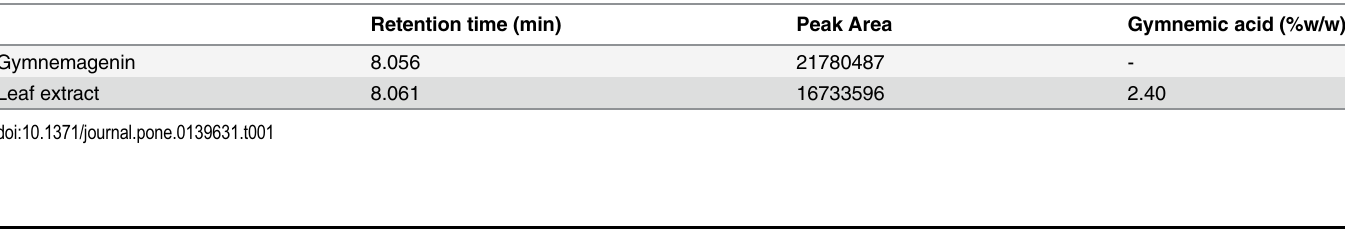
Table 1. HPLC parameters of reference standard and leaf